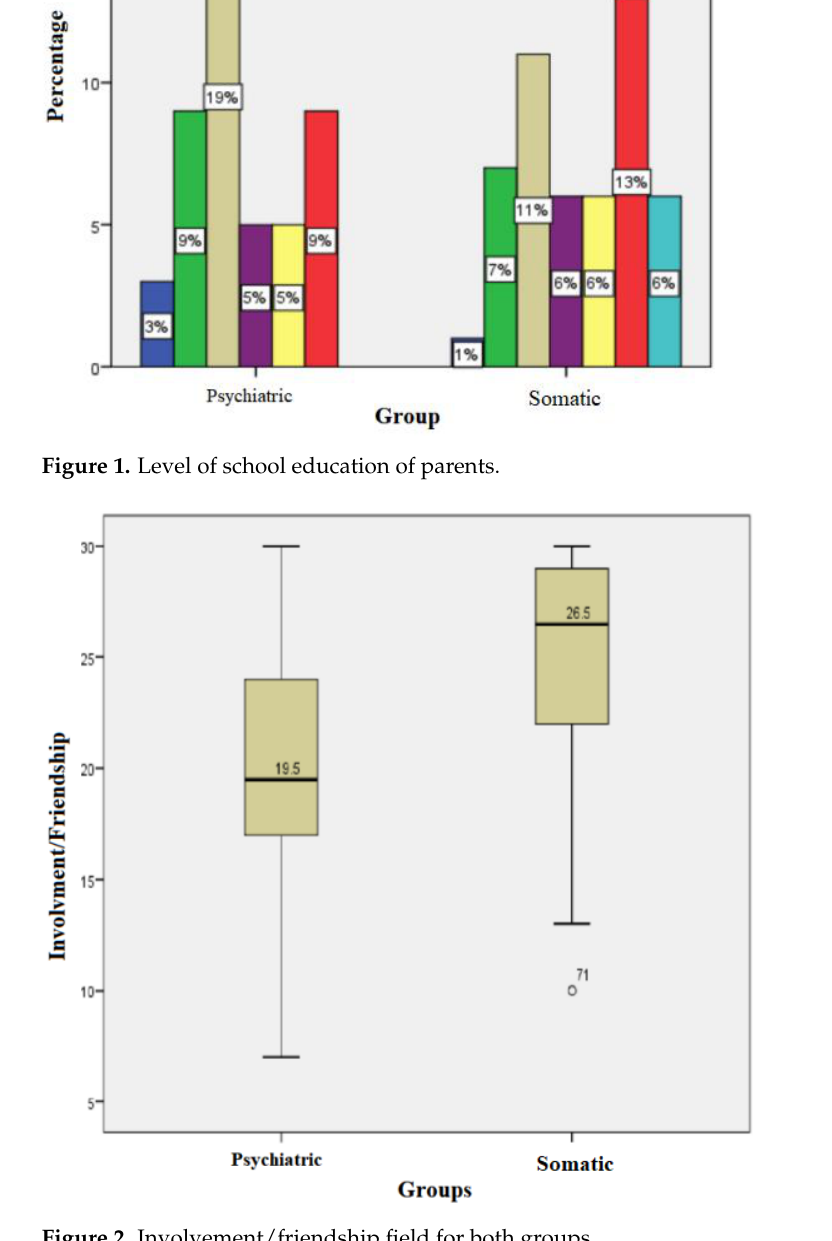
Figure 2. Involvement/friendship field for both groups.